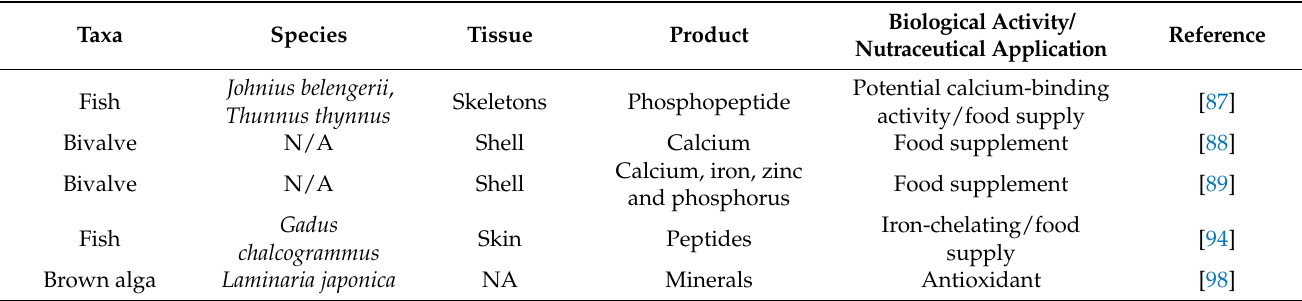
Table 2. Minerals and peptides carrying minerals from seafood wastes, together with taxa, species and tissue from which they were isolated, and their biotechnological